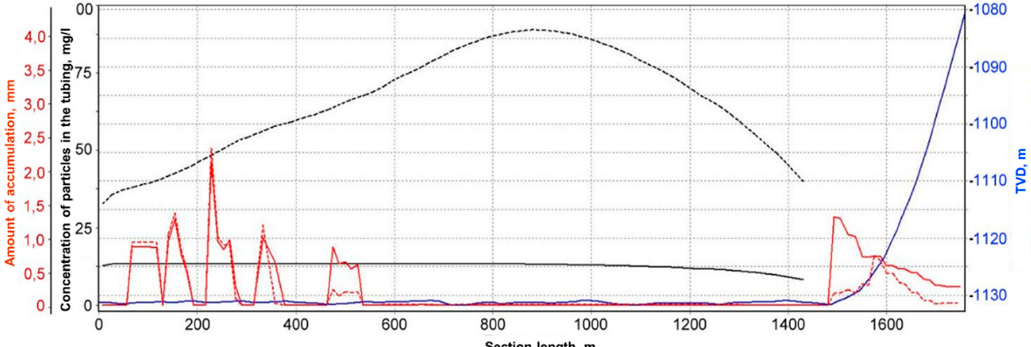
Figure 5. Burst recovery of particles with diameter of 0.060 mm at rate of 200 m 3 /d: well geometry from toe to pump inlet (blue line), particle concentration in the flow in tubing (black lines), and accumulation of “pillow” from particles (red lines) at different moments in time: solid lines—9 h; dashed lines—10 h.